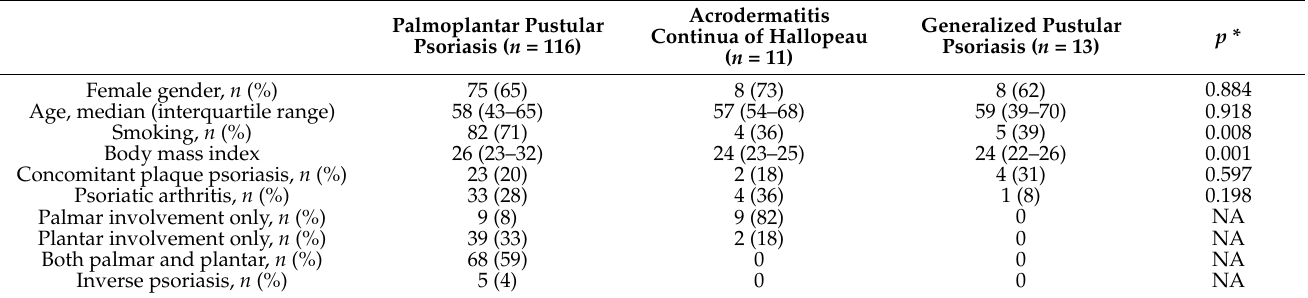
Figure 1. The number of incident cases of pustular psoriasis diagnosed from 2005 to 2021. Pal- moplantar psoriasis (black histograms), generalized pustular psoriasis (dashed histograms), and acrodermatitis continua of Hallopeau (grey histograms). Table 1. The main characteristics of patients with pustular psoriasis ( n = 140). Palmoplantar Pustular Psoriasis ( n =